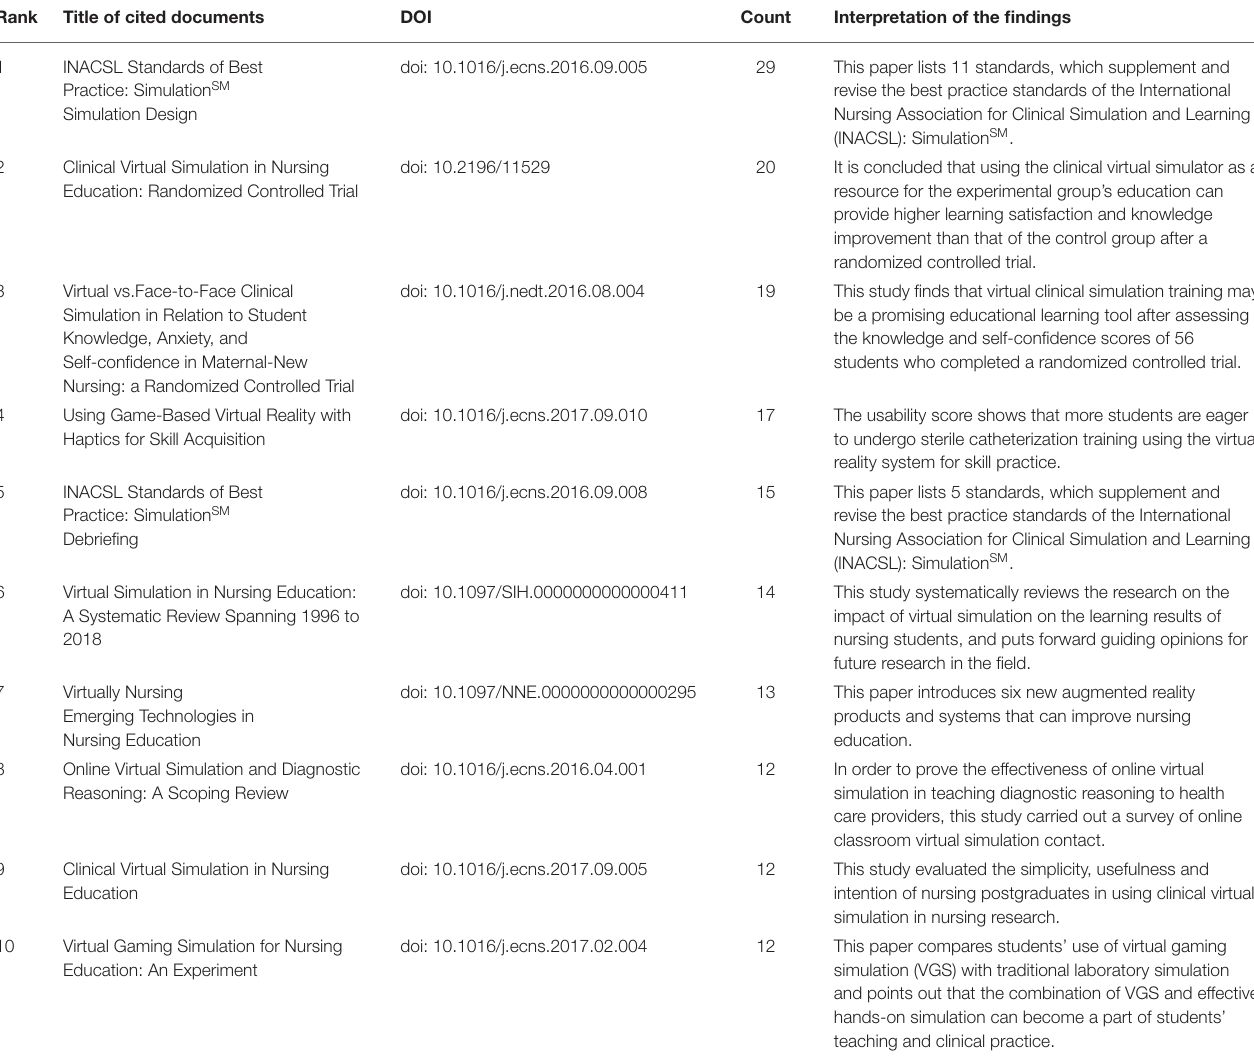
TABLE 6 | The top 10 references of publications on the application of VR in nursing from 2012 to